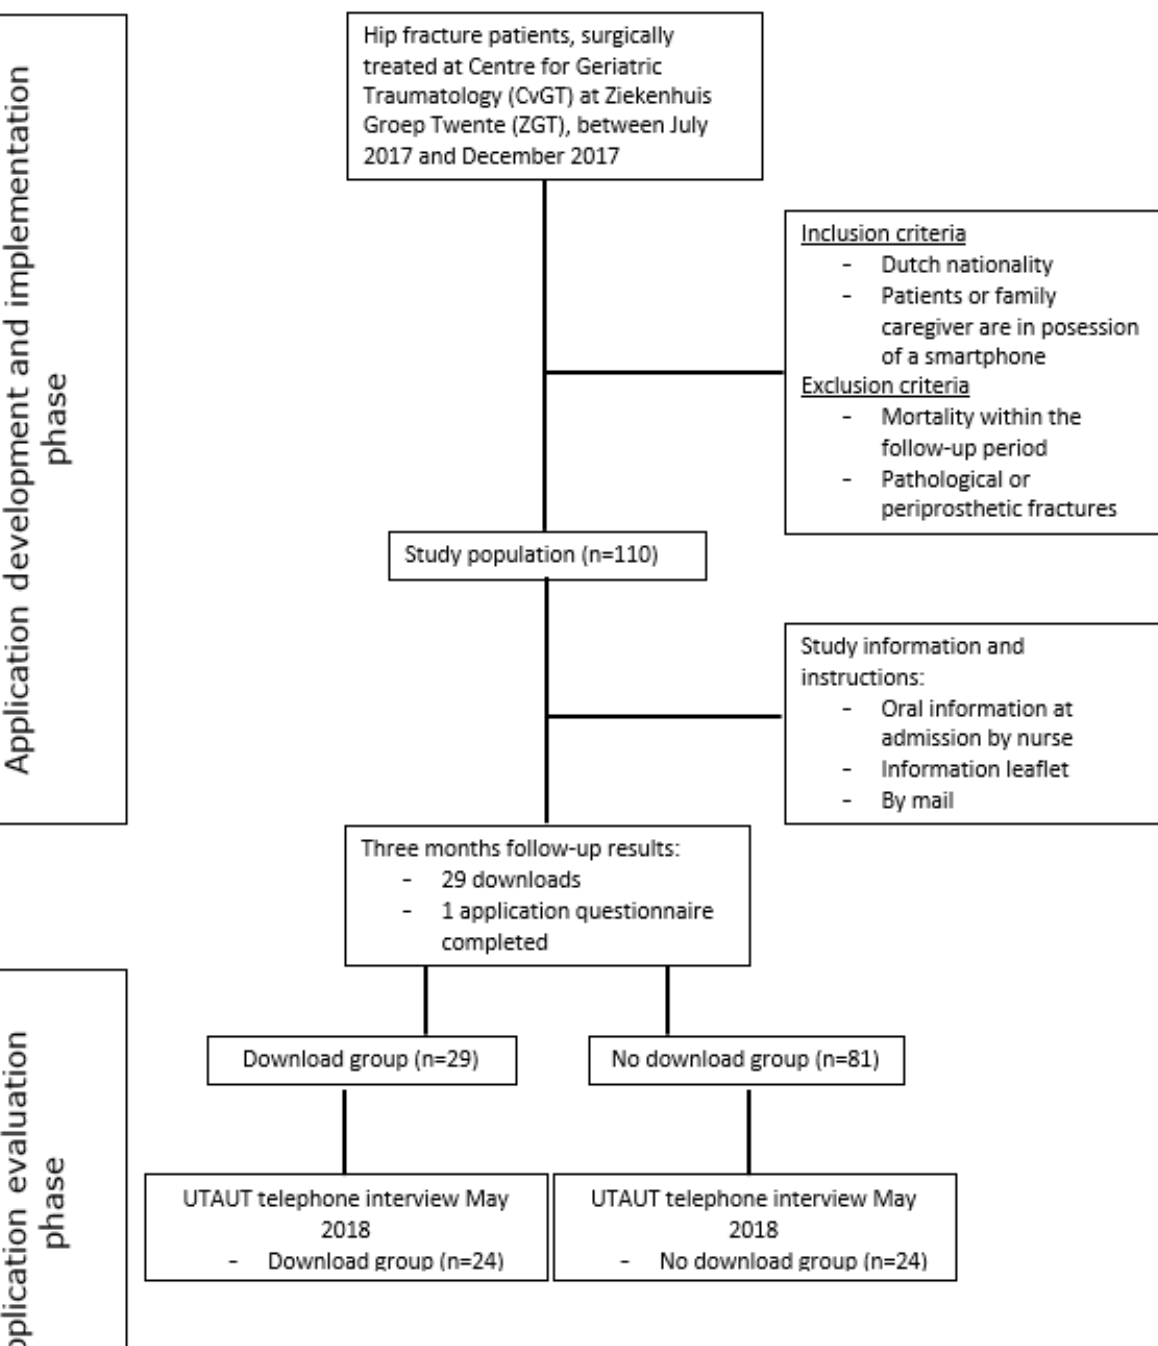
Figure 1. Study design